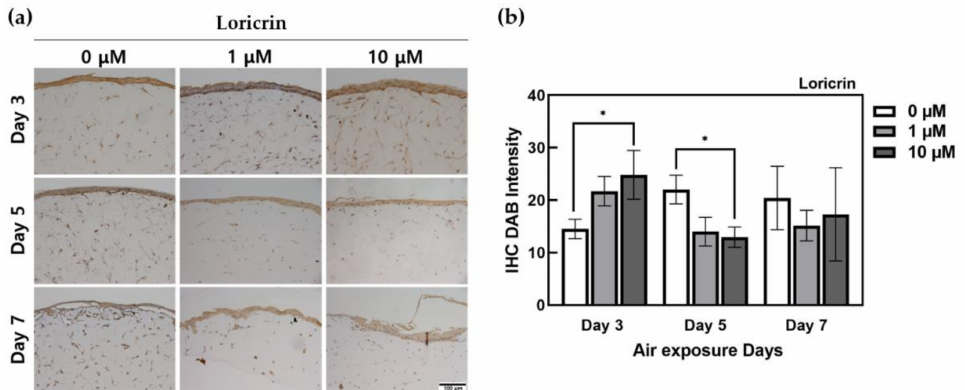
Figure 5. Immunohistochemistry-stained images for loricrin of HSEs treated α -lipoic acid concentration of 0, 1, and 10 µ M. ( a ) This is the result of loricrin expressed by IHC staining in HSEs. The x-axis is listed by ALA-treated concentration, and the y-axis is listed by ALA-treated period. The scale bar is 100 µ m. ( b ) This is a graph of quantification of DAB intensity for immunohistochemistry staining of loricrin protein using the ImageJ program. ( n = 4; *, p < 0.05 vs. 0 µ M for each period).